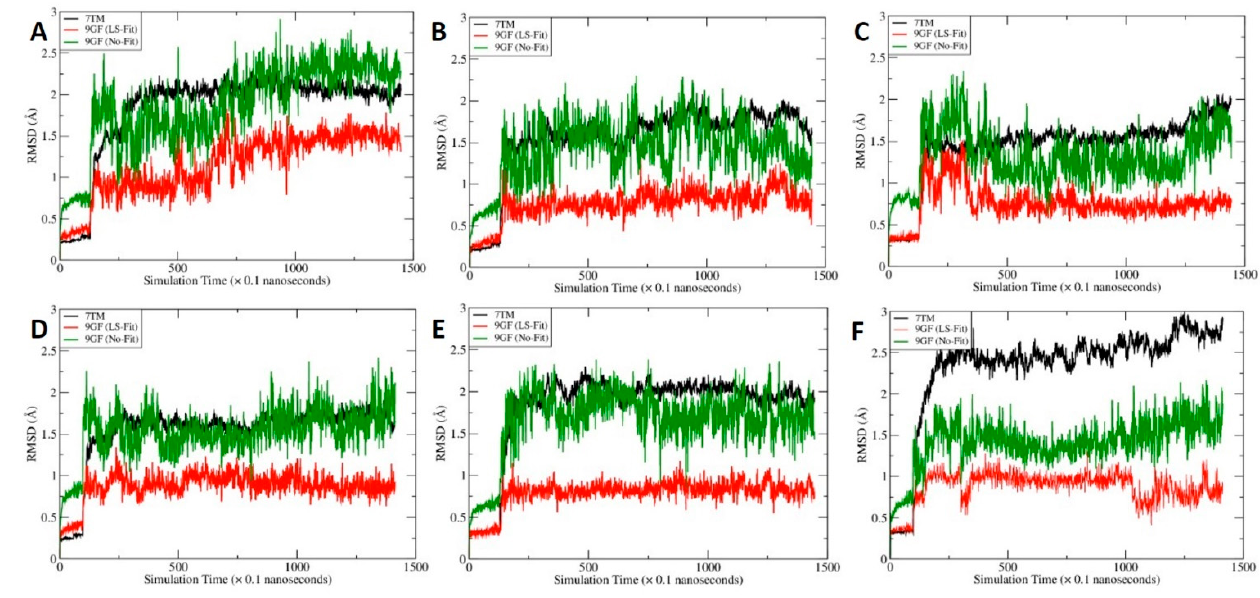
Figure 7. The time course of root–mean–square deviations (RMSD) of mainchain atoms of the transmembrane domains (7TM, black), heavy atoms of CP55940 after least-square (LS) fitting (9GF, red) and heavy atoms of CP55940 without fitting (9GF, green). To calculate the No-Fit RMSDs for CP55940, the mainchain atoms of 7TM were first aligned and the resulting translation–rotation matrix were then applied to the ligand. After the coordinate transformation, the RMSDs were calculated directly. ( A ) CP55940/CB2 without C-2 binding, ( B ) site B, ( C ) site G, ( D ) site H, ( E ) site I and ( F ) site J .